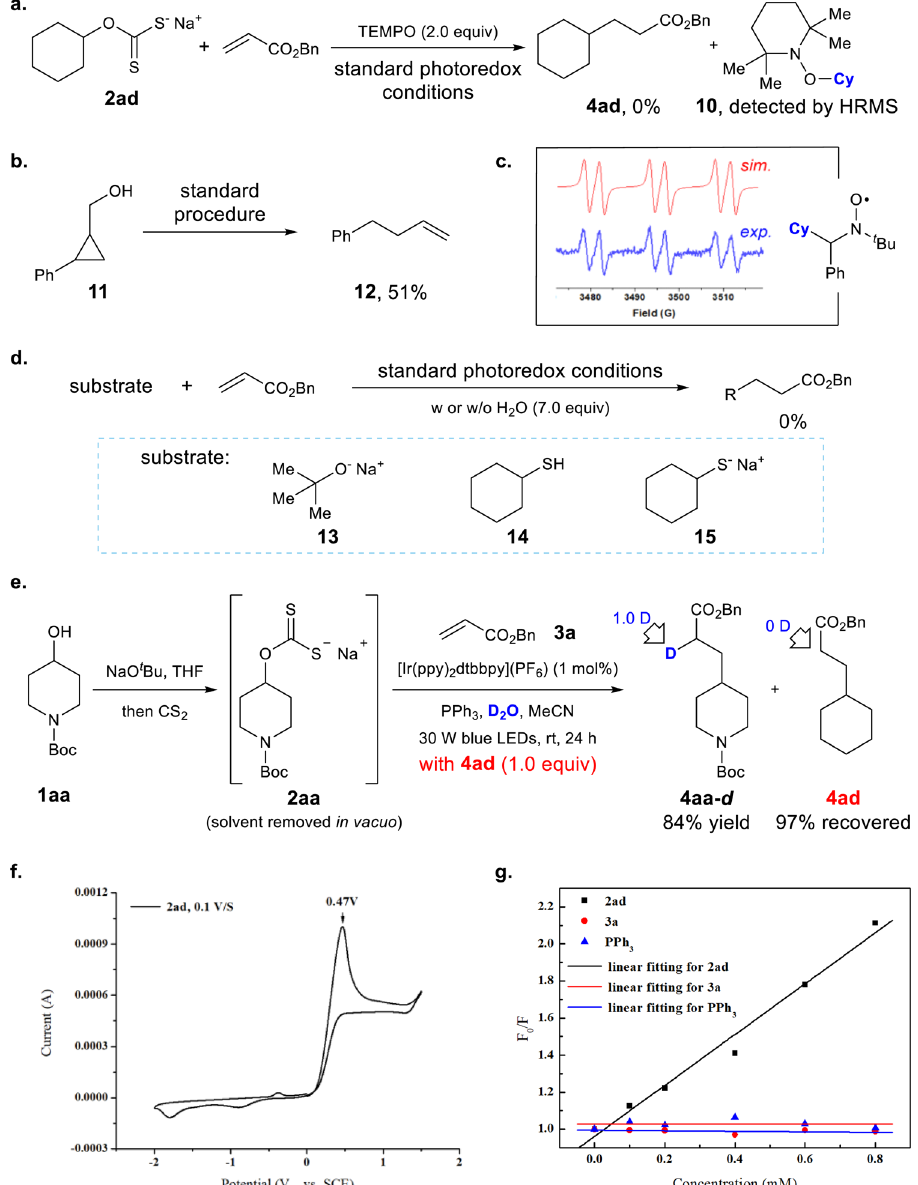
Fig. 7 Probing the mechanism. a Radical trap experiment; b radical clock experiment; c EPR experiment ( g = 2.00619, A N = 14.9123 G, A H = 3.41209 G); d probing the intermediate; e deuterium-labeling experiment; f cyclic voltammogram; g Stern – Volmer fl uorescence quenching